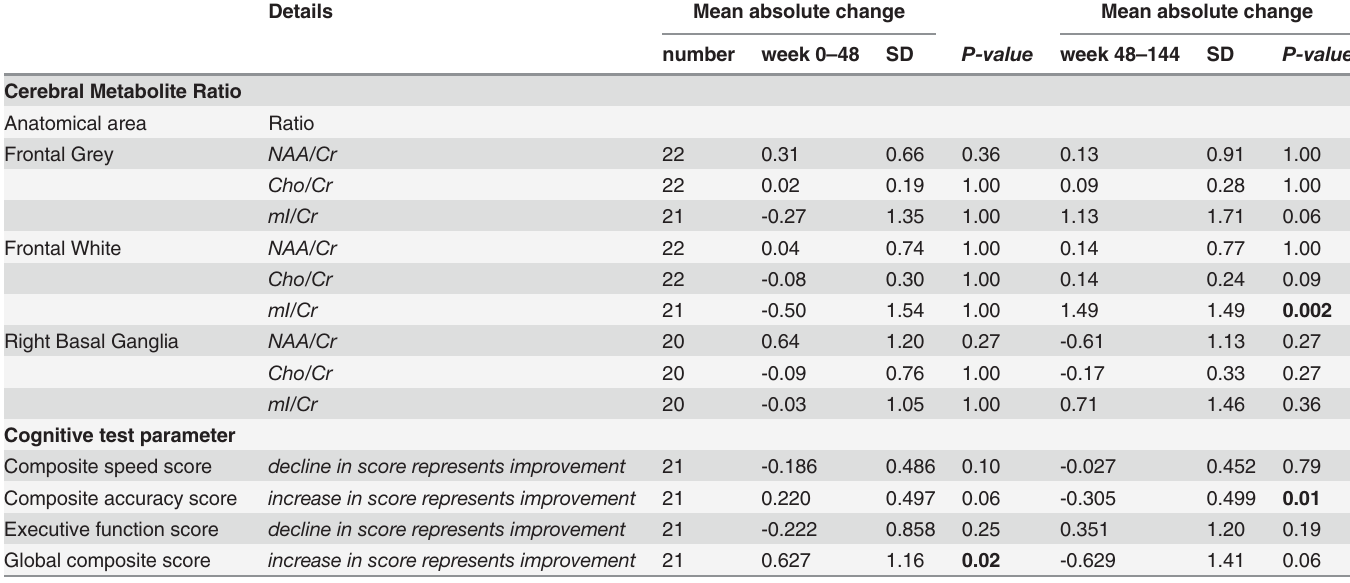
Table 2. Changes in cerebral function parameters over 3